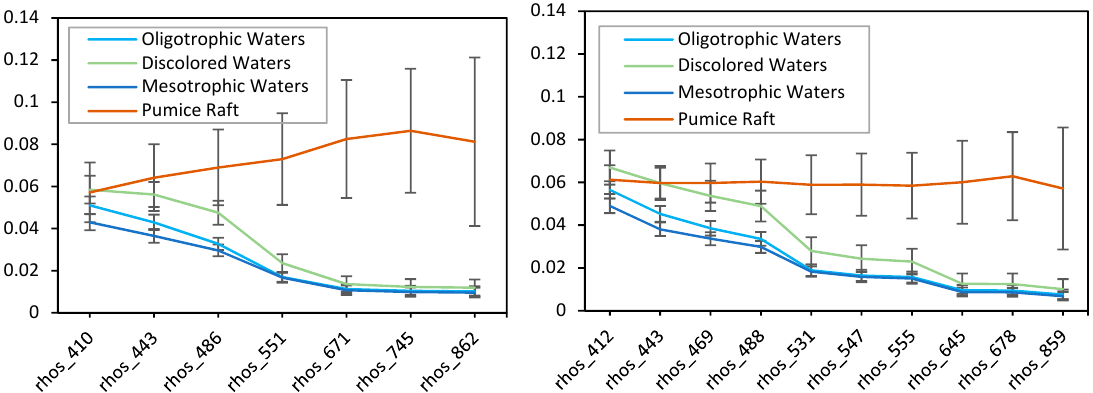
Figure 3. Satellite reflectance data ρ (rhos) spectra of the different water types for VIIRS (left) and MODIS (right). Averages of 3 days of data from each sensor (10, 11, and 12 August for VIIRS; 11, 12, and 14 August for MODIS), with their standard deviations calculated.